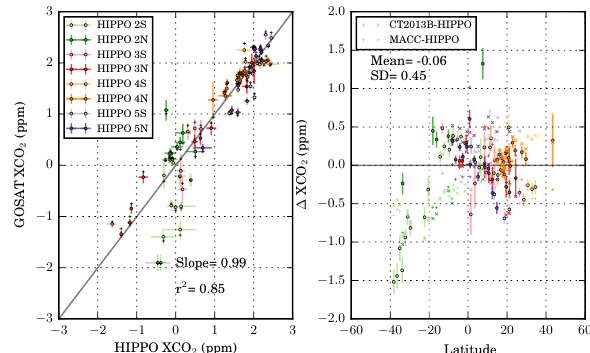
Figure 7. Left: scatter plot of normalized (with campaign average) XCO 2 computed from individual HIPPO profiles ( x axis) against corresponding GOSAT data. Right: difference plot of XCO 2 against latitude. Campaigns as well as north and southbound tracks are color coded. For comparison, the right panel also shows the model– HIPPO differences in smaller symbols without error bar (MACC as “ + ”, CT2013B as “x”).